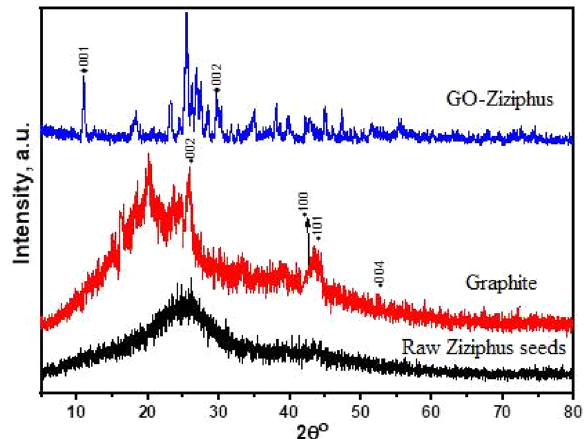
Figure 2. XRD patterns for raw ziziphus seeds, graphite and GO- ziziphus